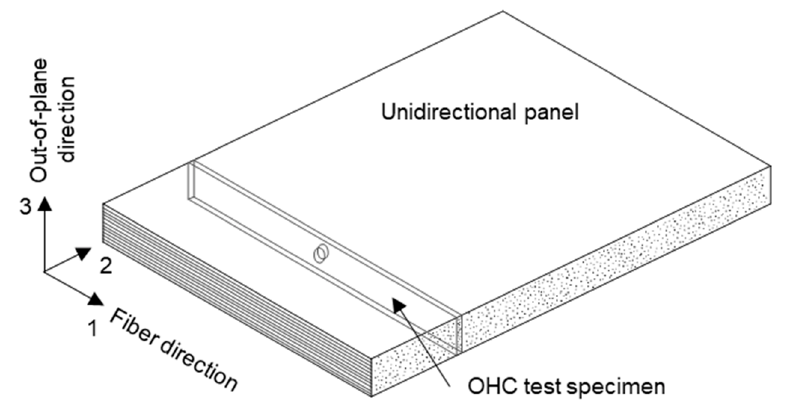
Figure 1. Open-hole compression (OHC) test specimen machined from a 12.8 mm (0.5 in) thick unidirectional panel.